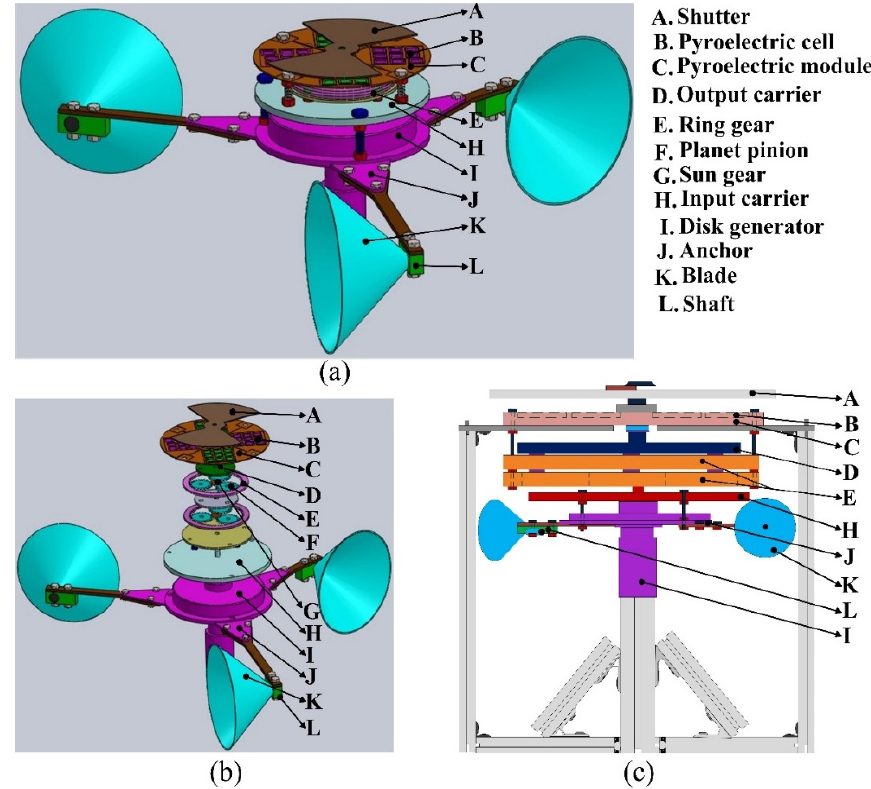
Figure 1. Schematic diagram of the pyroelectric harvester integrating solar radiation with wind power: ( a ) assembly drawing; ( b ) exploded view; and ( c ) lateral